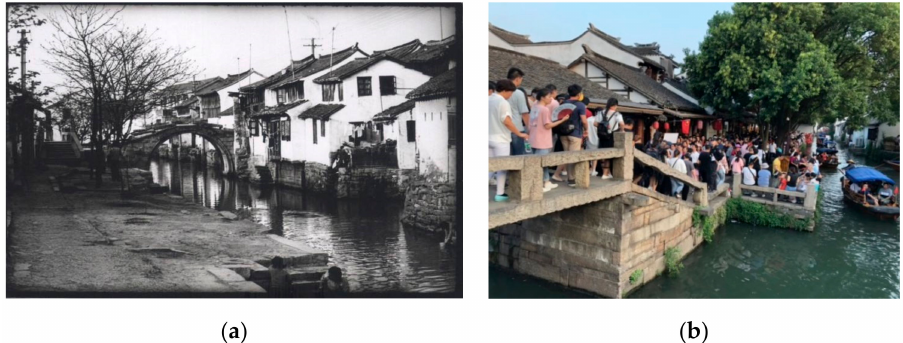
Figure 1. Zhouzhuang ancient town before and after tourism development: ( a ) Zhouzhuang in the 1970s–1980s; ( b ) Zhouzhuang during National Day Golden Week in 2019 (photo ( a ) provided by Kunshan local Chronicles o ffi ce; photo ( b ) taken by the authors).